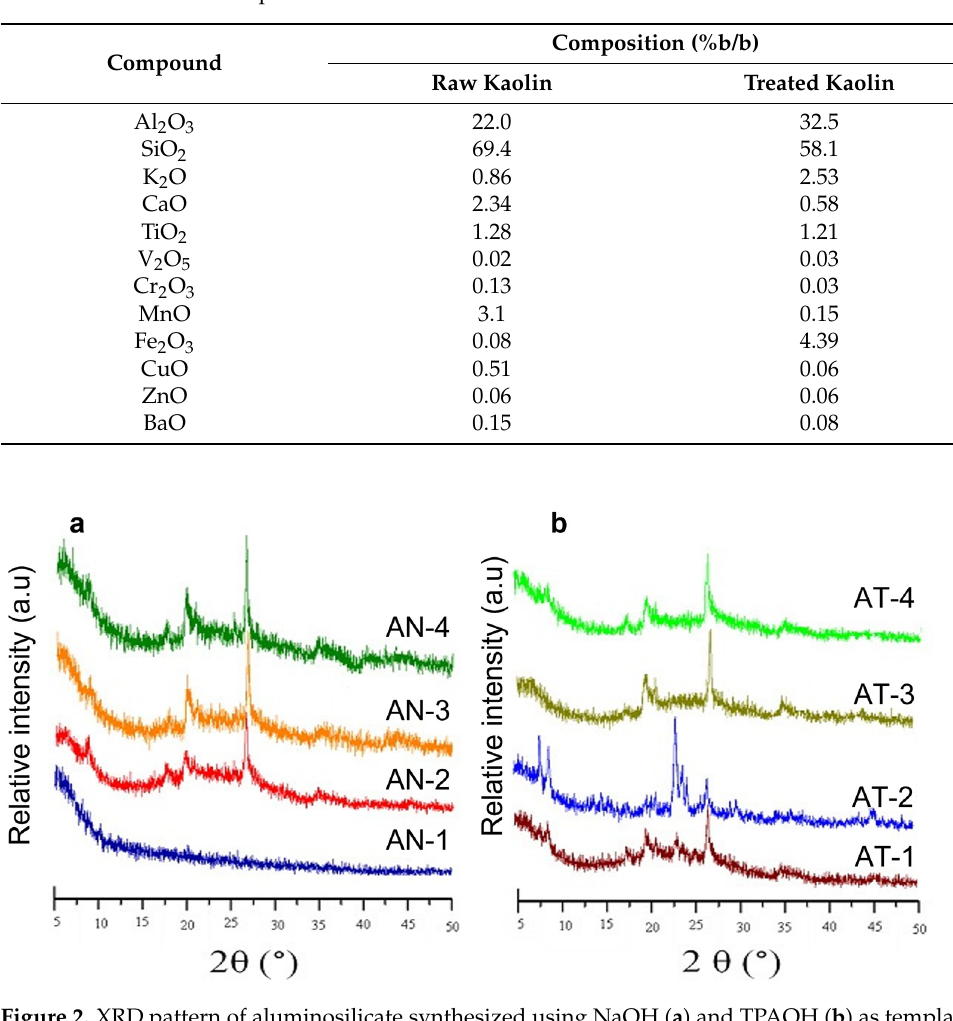
Figure 2. XRD pattern of aluminosilicate synthesized using NaOH ( a ) and TPAOH ( b ) as